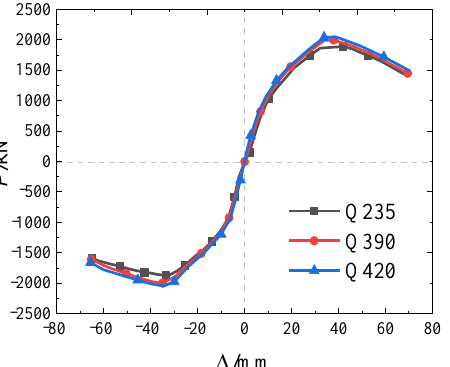
Figure 25. Load–displacement skeleton curve of models with different RCFSTK steel Figure 25. Load – displacement skeleton curve of models with different RCFSTK steel strengths.